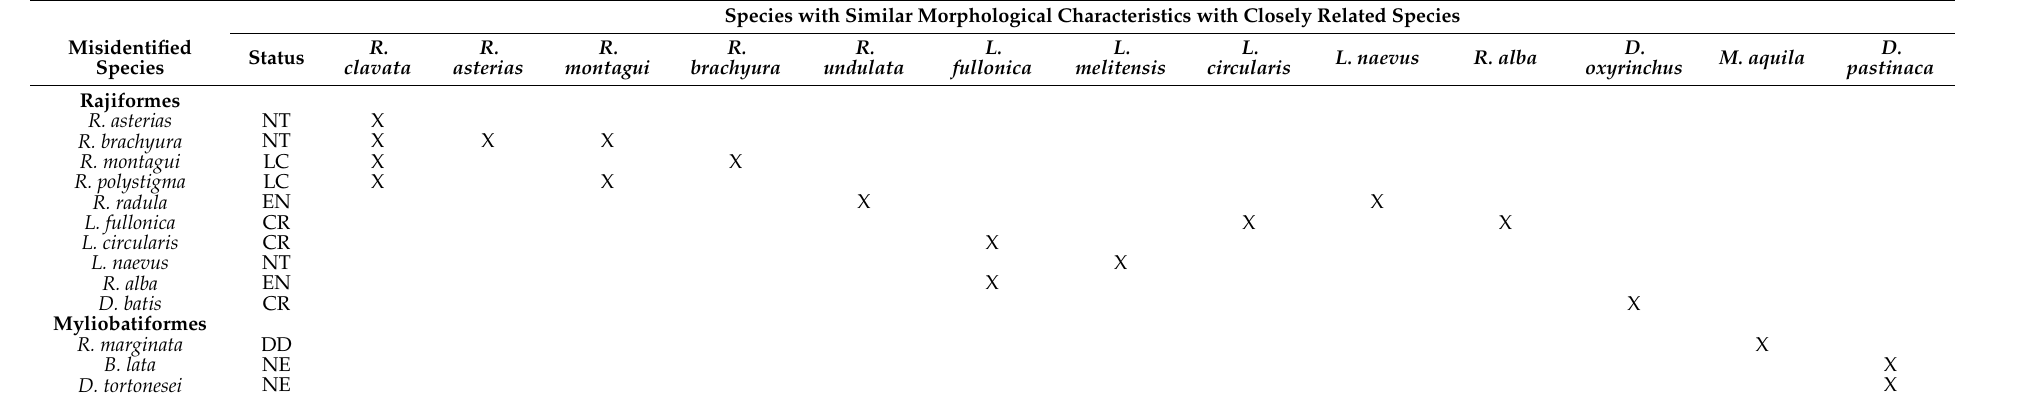
Table 2. Identification issues documented by fisheries observers, due to the high morphological variability of the external features in skates and rays. Species with Similar Morphological Characteristics with Closely Related